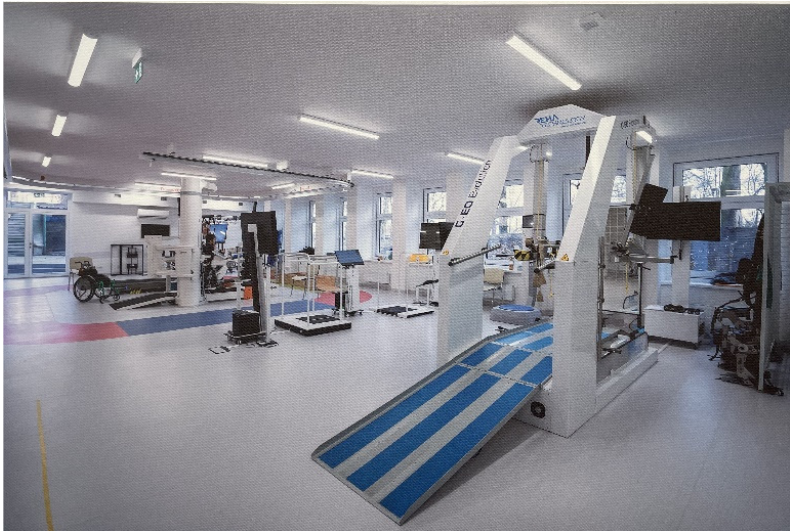
Figure 7 . Orthopaedic hospital in Poznan, source: author’s own material